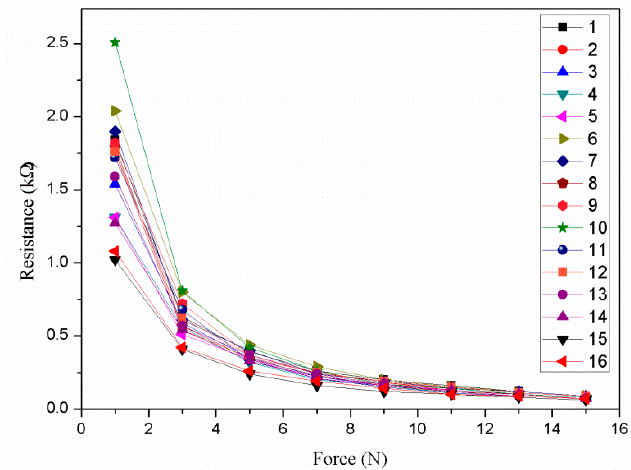
Figure 12. The mapping relationship between the force and resistance of the sixteen small squares of the Velostat film.